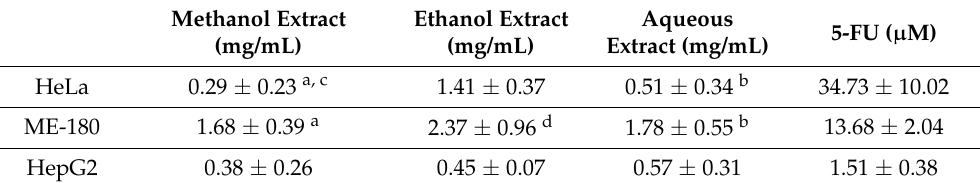
Figure 5. UPLC-UV-MS analysis on positive node for methanol extract with identified peaks of 1. Pseudopurpurin, 2. Morindaparvin A.